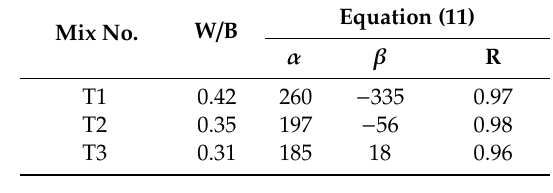
Table 4. Equation Parameters of the empirical Model.